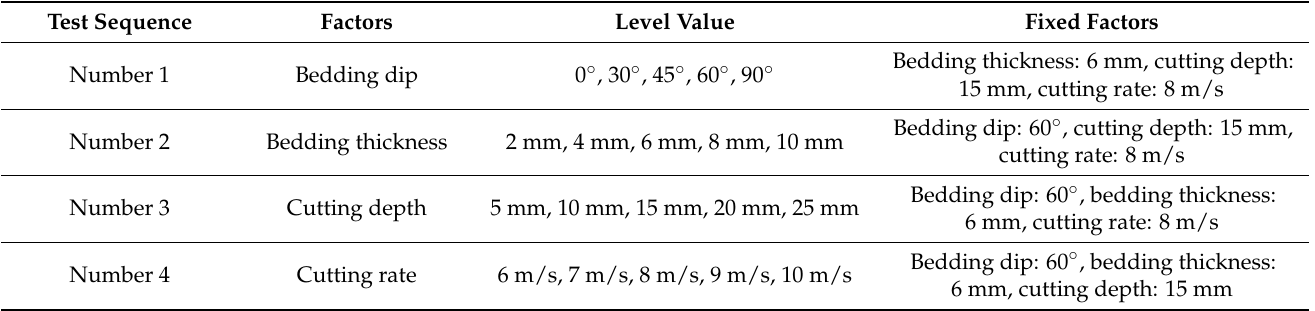
Table 3. Simulated working conditions of a PDC cutter cutting.